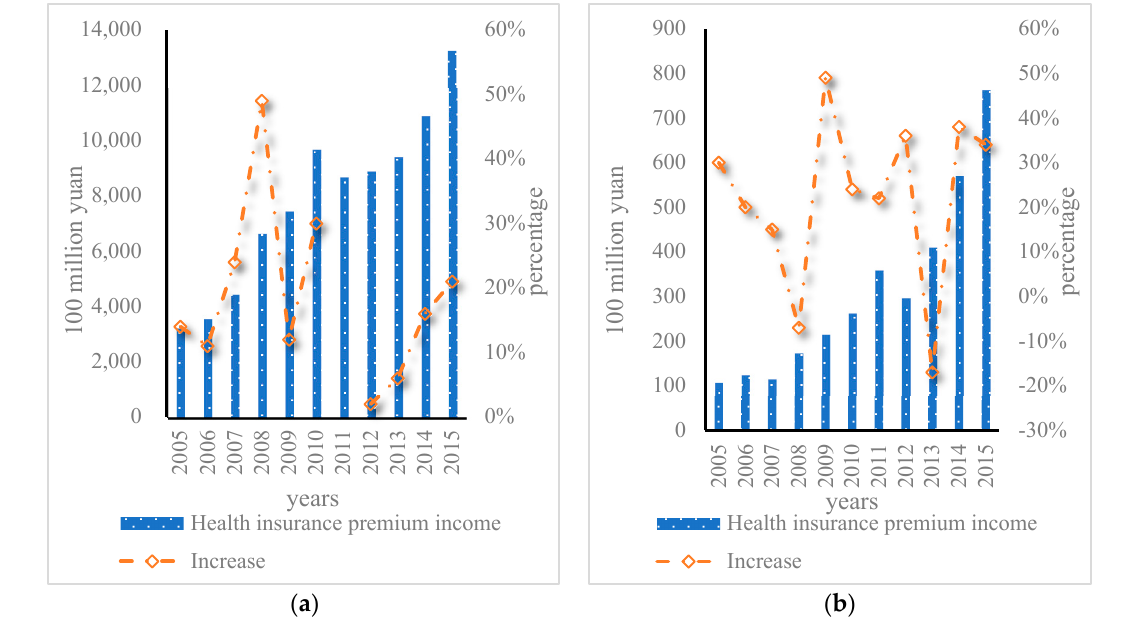
Figure 3. Commercial health insurance premium income, 2005–2018. ( a ) Health insurance premium income and increase. ( b ) Health insurance claims and benefits and increase.